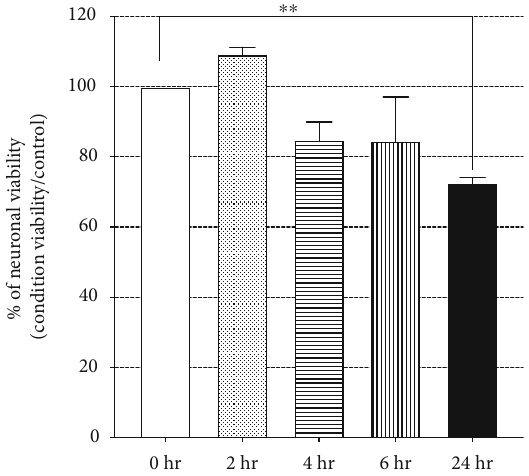
Figure 1: E ff ect of high glucose medium (45 mM) on DRG culture viability at di ff erent time